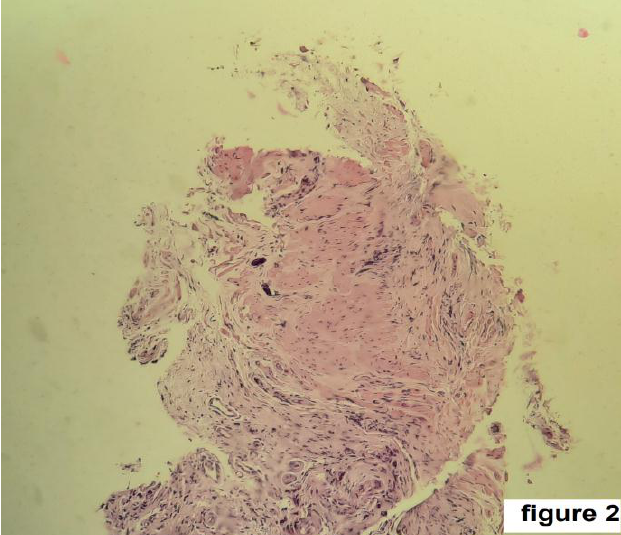
Figure.2: Ureteric biopsy revealed nonspecific mucosal